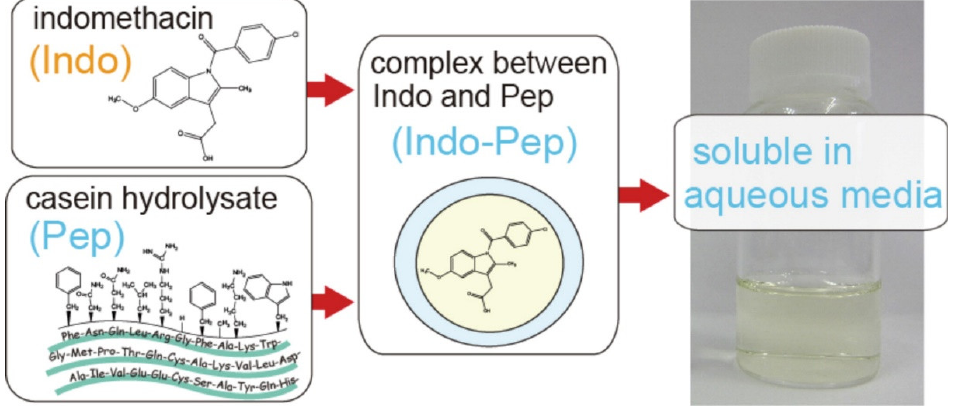
Figure 4. Enhancement of drug solubility of poorly aqueous soluble drugs through complexation with peptides, adapted with permission from [98].